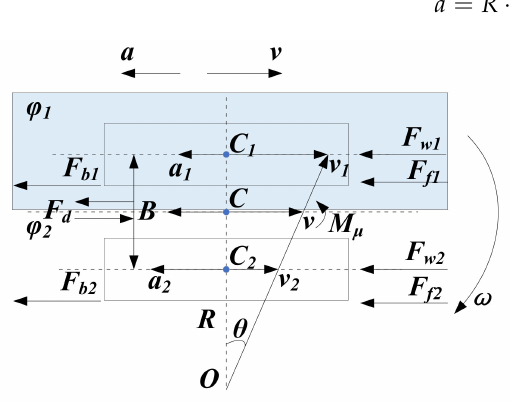
Figure 9. Force analysis of the two tracks on the split road under braking